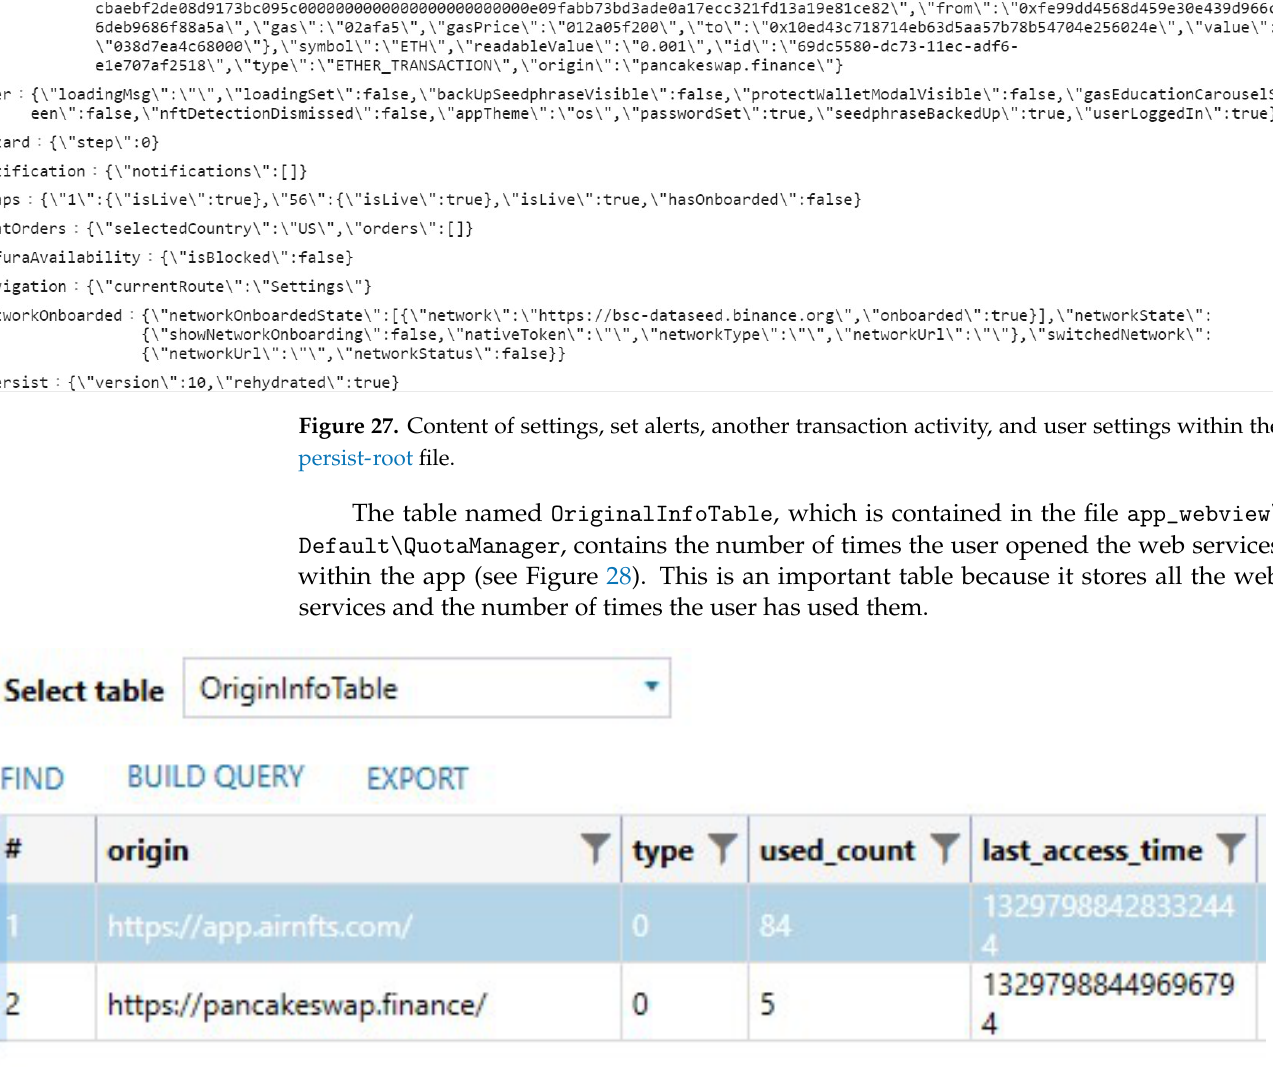
Figure 28. Number of times that the user opened the web services within the